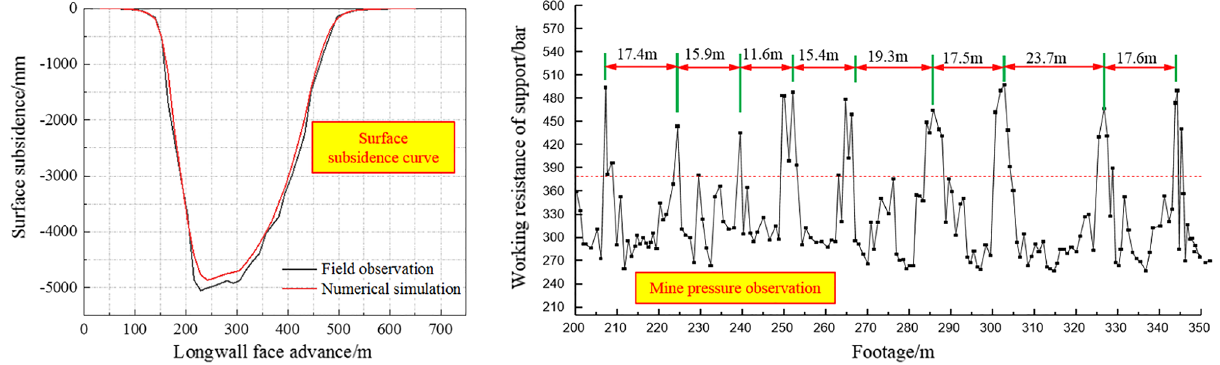
Figure 5. The validation of numerical model.